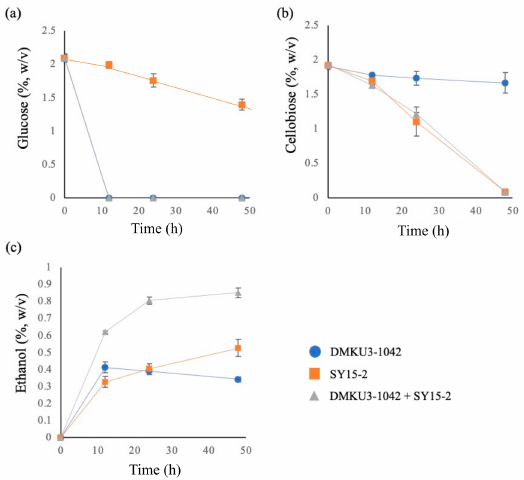
Figure 6. Co-culture of SY15-2 and the parental strain in the medium supplemented with cellobiose and glucose. The same volumes of K. marxianus DMKU3-1042 and SY15-2 pre-cultures were inoc- ulated at a total inoculum size of 0.1% into 2% glucose and 2% cellulose medium at 40 ◦ C under a shaking condition at 160 rpm. As a control, the K. marxianus DMKU3-1042 pre-culture or the SY15-2 pre-culture was inoculated at an inoculum size of 0.1%. At the times indicated, the concentrations of glucose ( a ), cellobiose ( b ) and ethanol ( c ) in the medium were determined by HPLC as described in Materials and Methods. Error bars indicate standard deviation of three independent